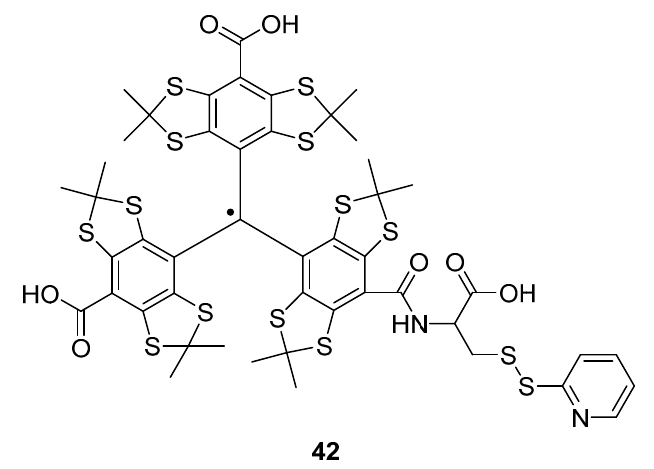
Figure 8. A cysteine specific TAM spin label CT02-TP 42